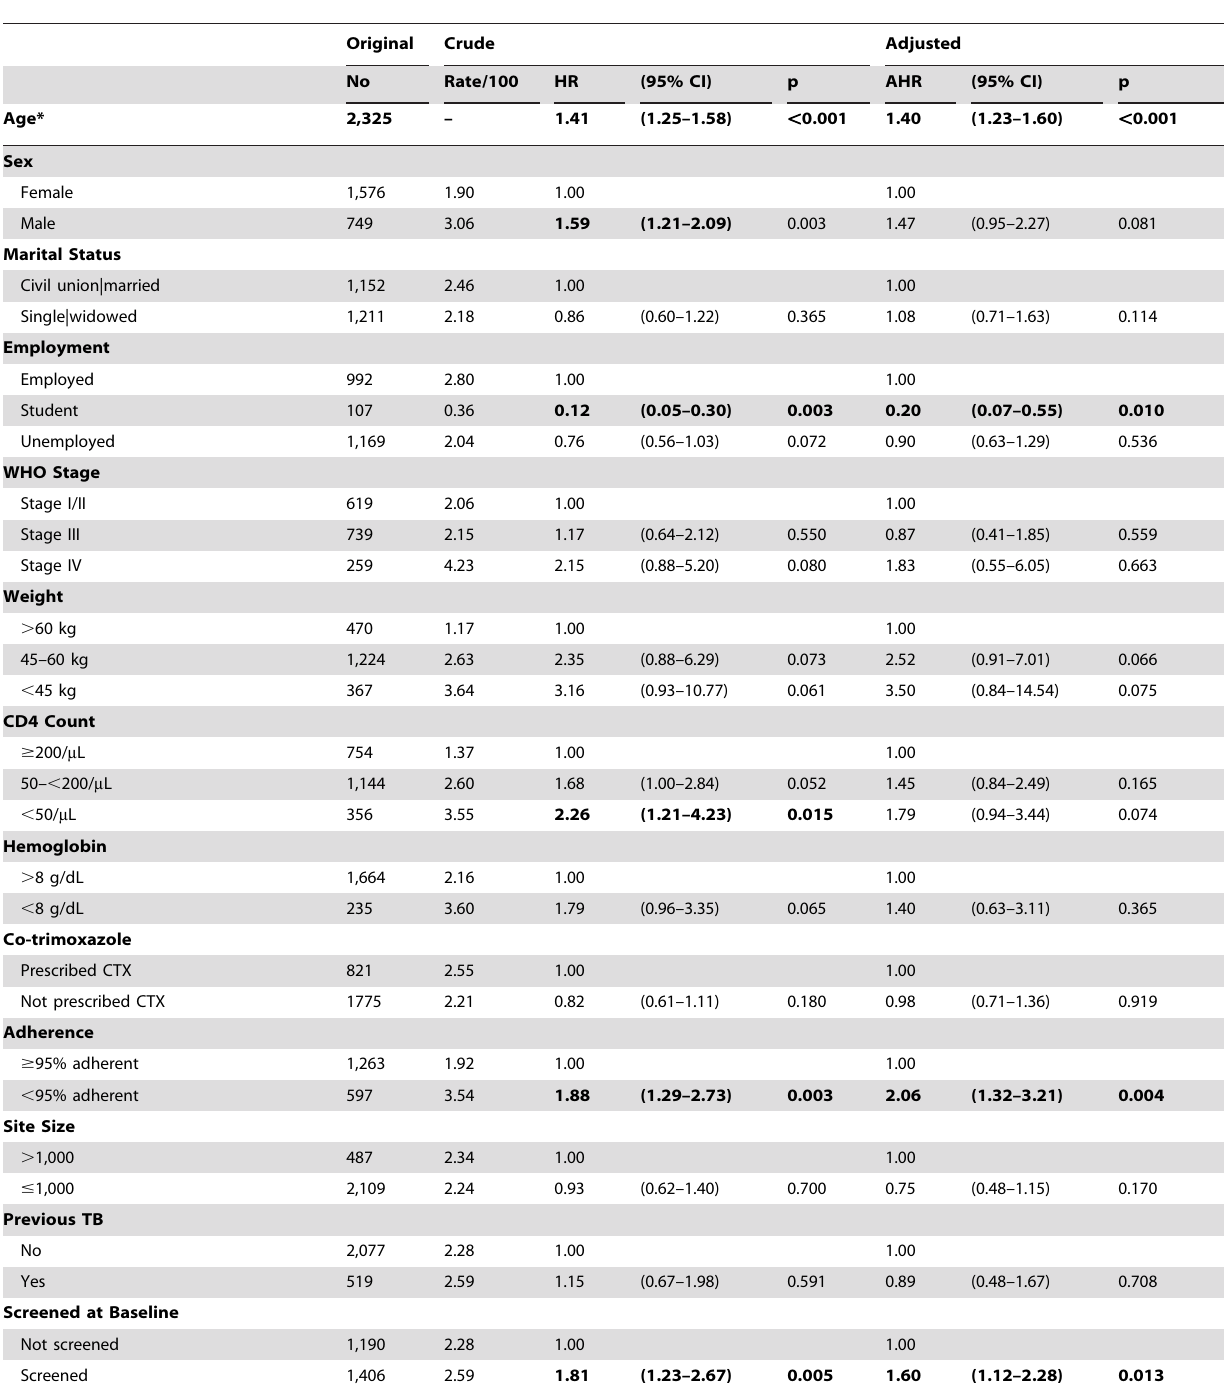
Table 2. Cox Proportional Hazards Analysis of Patient Characteristics Associated with TB Incidence during ART